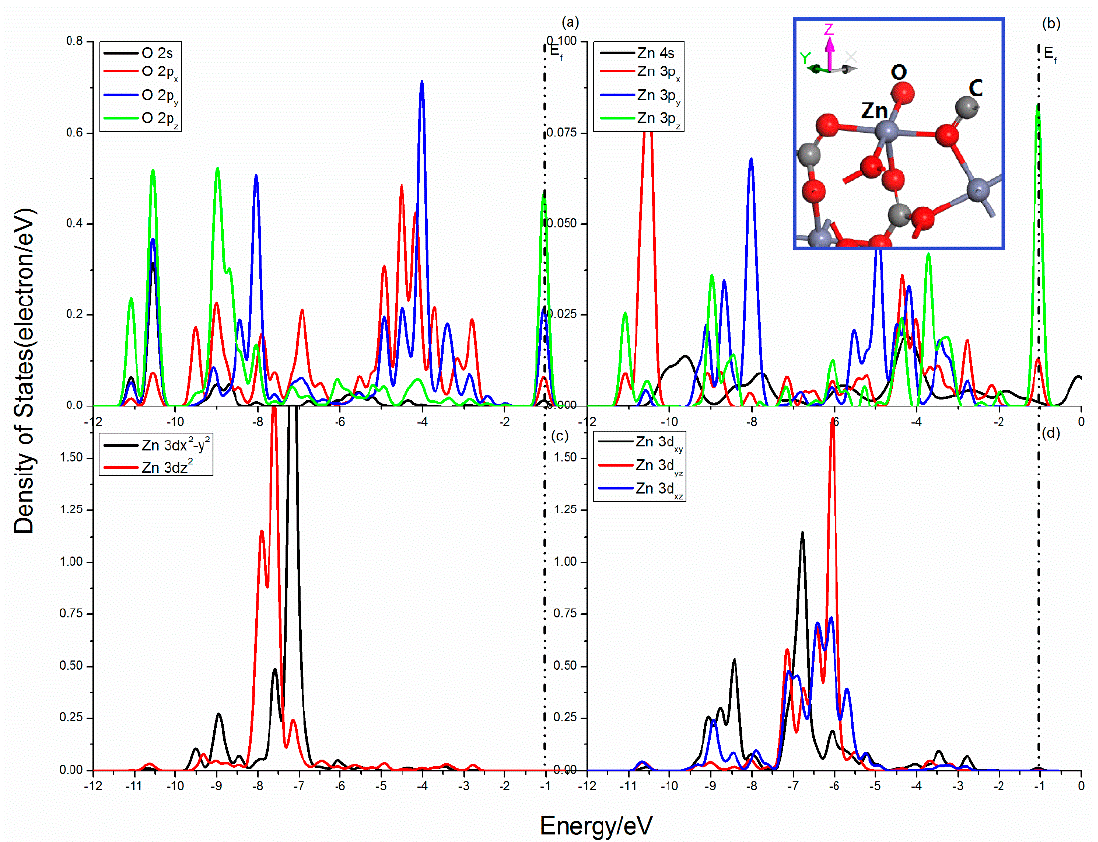
Figure 7. Projected DOS of O and Zn of smithsonite (101) surface: ( a ) O 2s, 2p x , 2p y and 2p z states; ( b ) Zn 4s, 3p x , 3p y and 3p z states; ( c ) Zn 3d x2 –y2 and 3d z2 states; ( d ) Zn 3d xy , 3d xz and 3d yz states.